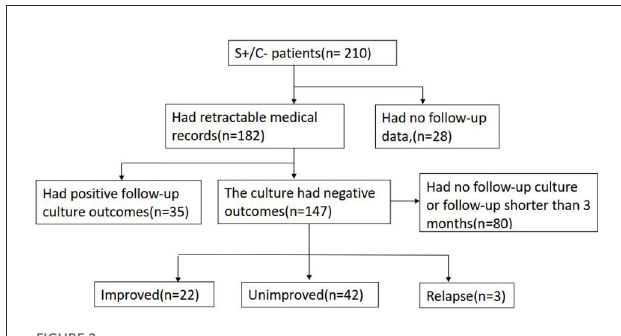
FIGURE2 The status summary after S + /C– outcomes for the enrolled patients.